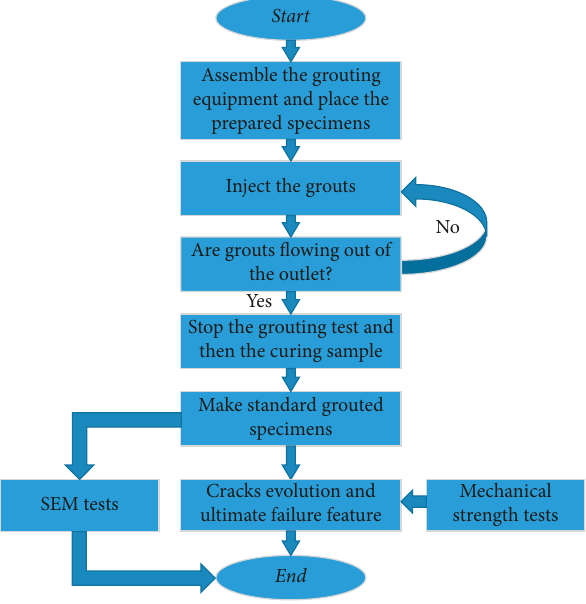
Figure 6: Testing